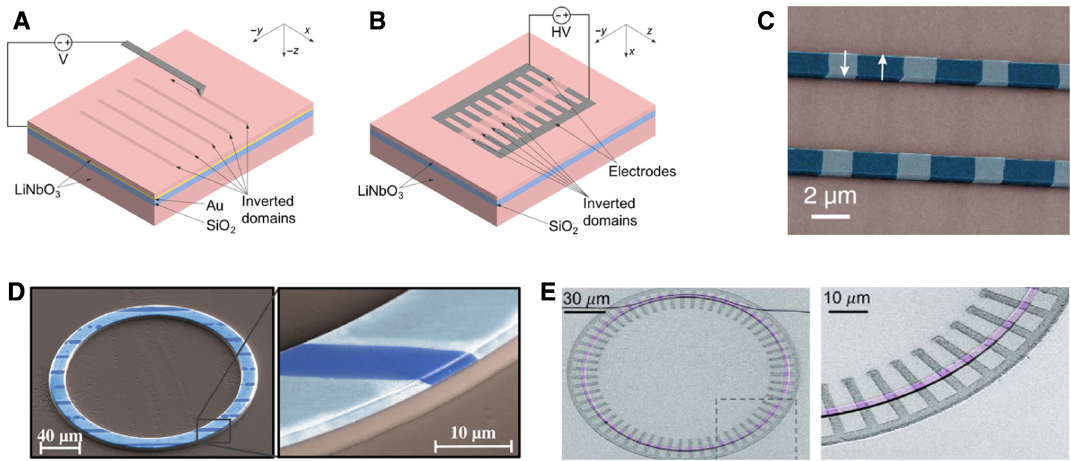
Figure 14: Fabrication procedures and results of PPLN structures. (A, B) Schematic diagrams of fabricating PPLN on (A) Z-cut LN thin film and (B) X-cut LN thin film. Reprinted with permission from Boes et al. [42]. (C–E) False-color scanning electron microscope images of (C) the X-cut PPLN waveguide [107], (D) translational symmetry PPLN microring [108], and (E) rotational symmetry PPLN microring [109]. Reprinted with permission from [107–109]. © The Optical